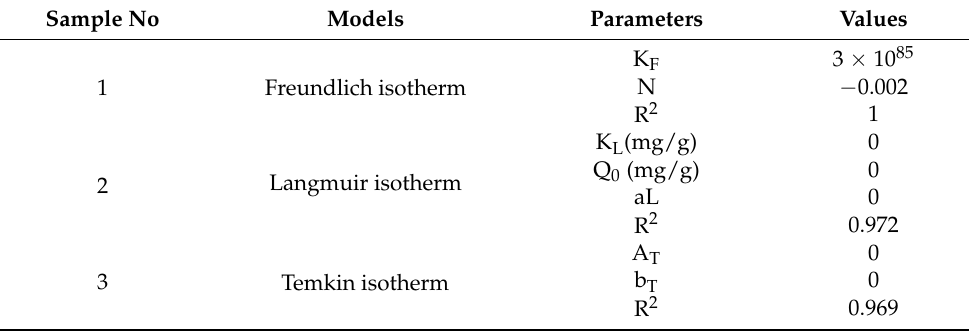
Figure 14. Temkin isothermal plot. Table 5. Calculated parameters for isothermal